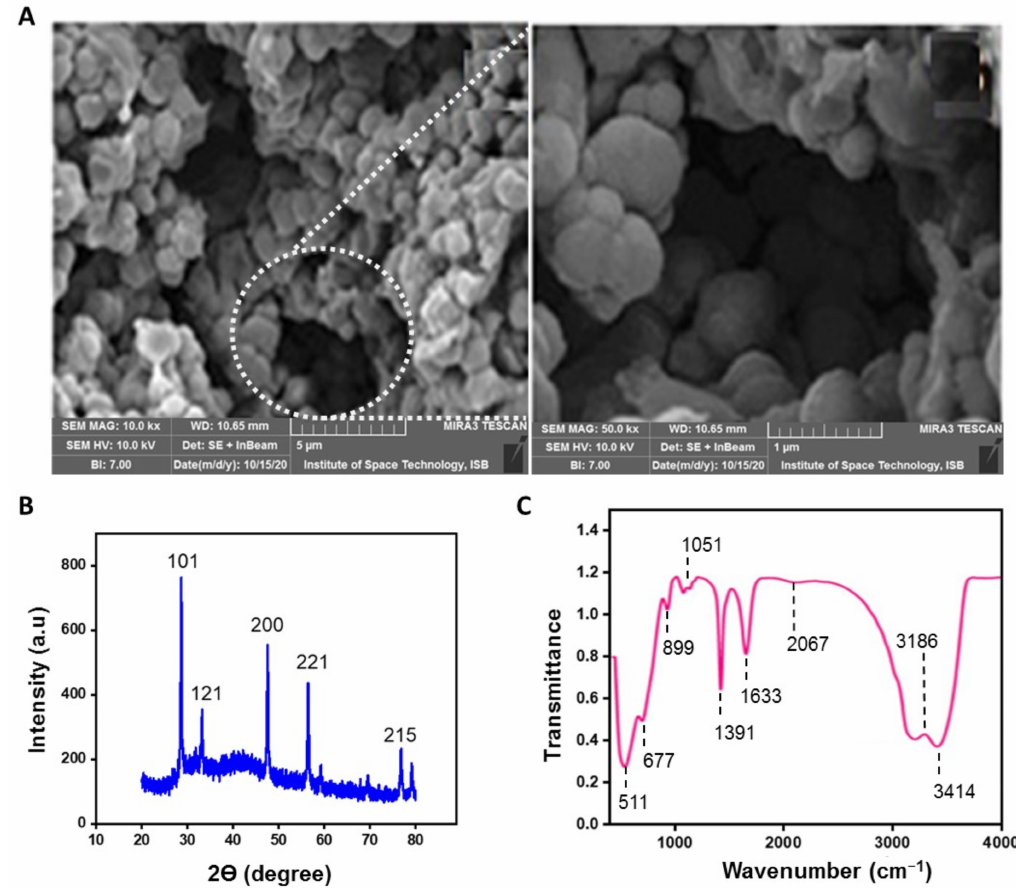
Figure 3. ( A ) SEM images of the biosynthesized TiO 2 NPs ( Left : scale bar 5 µ m, magnification 10 × ; Right : scale bar 1 µ m, magnification of the selected area 50 × ); ( B ) XRD of the biosynthesized TiO 2 NPs; ( C ) FTIR spectrum of the biosynthesized TiO 2